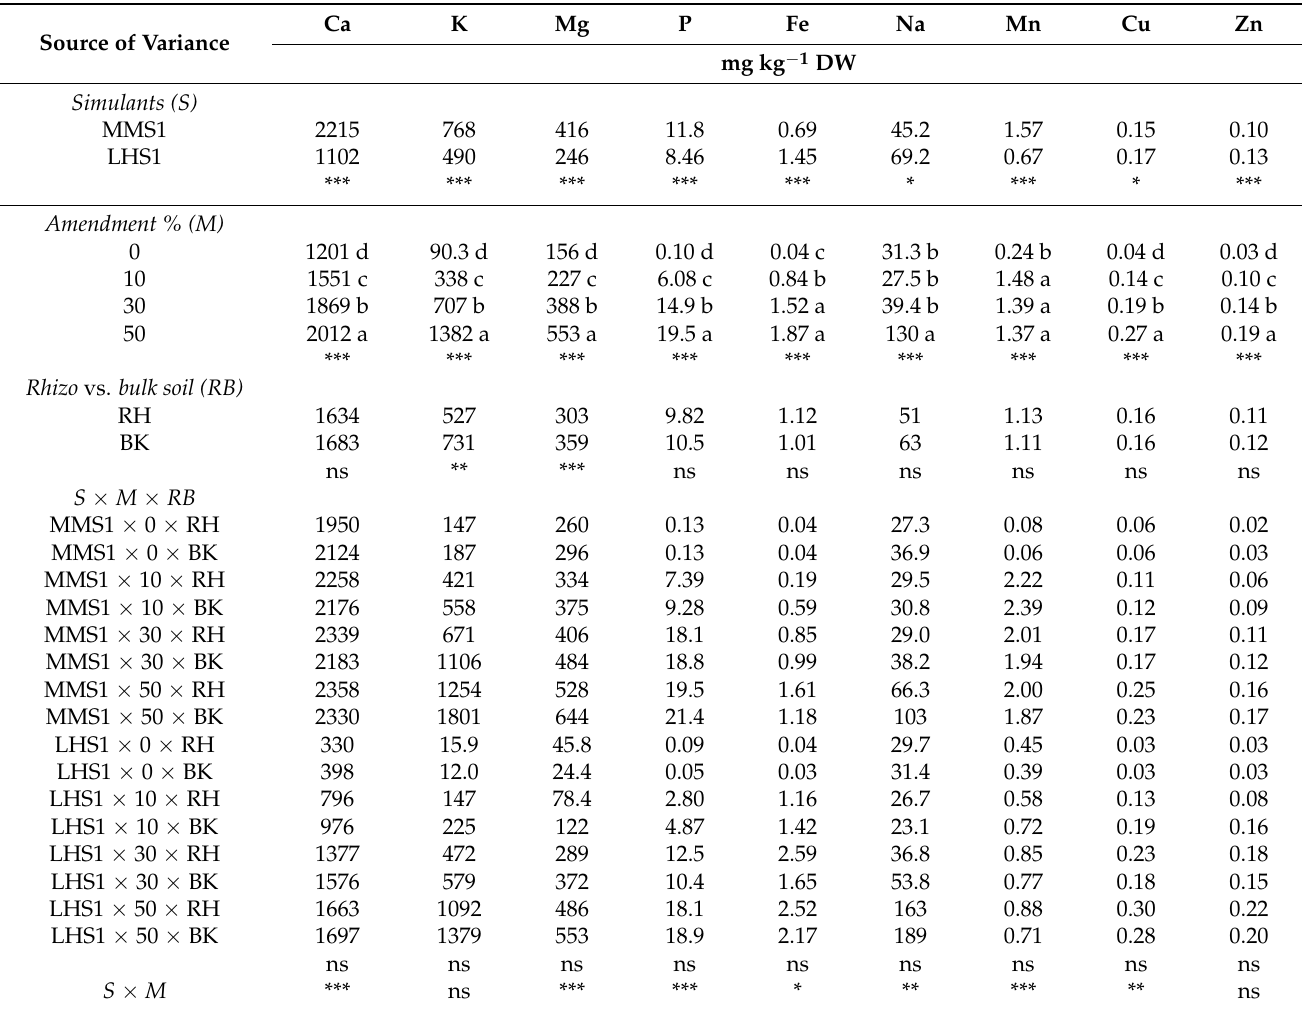
Table 5. Concentration (mg kg − 1 DW) of main macro and micronutrients in different mixtures of MMS-1 or LHS-1 simulants and manure (simulant/manure rates: 100:0, 90:10, 70:30, 50:50; w / w %), separated in rhizo and bulk soil after lettuce growth, extracted by 1 M NH 4 NO 3 ( n =